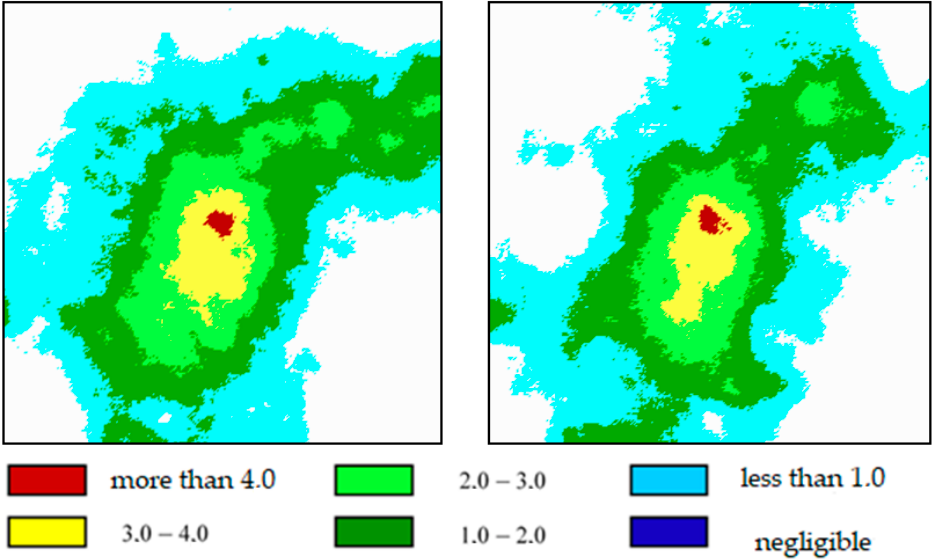
Figure 11. Density of pollution in relative units (work surfaces). Hurst index 𝐻 = 0.9 ; scale factor 𝑟 = 1.41 .